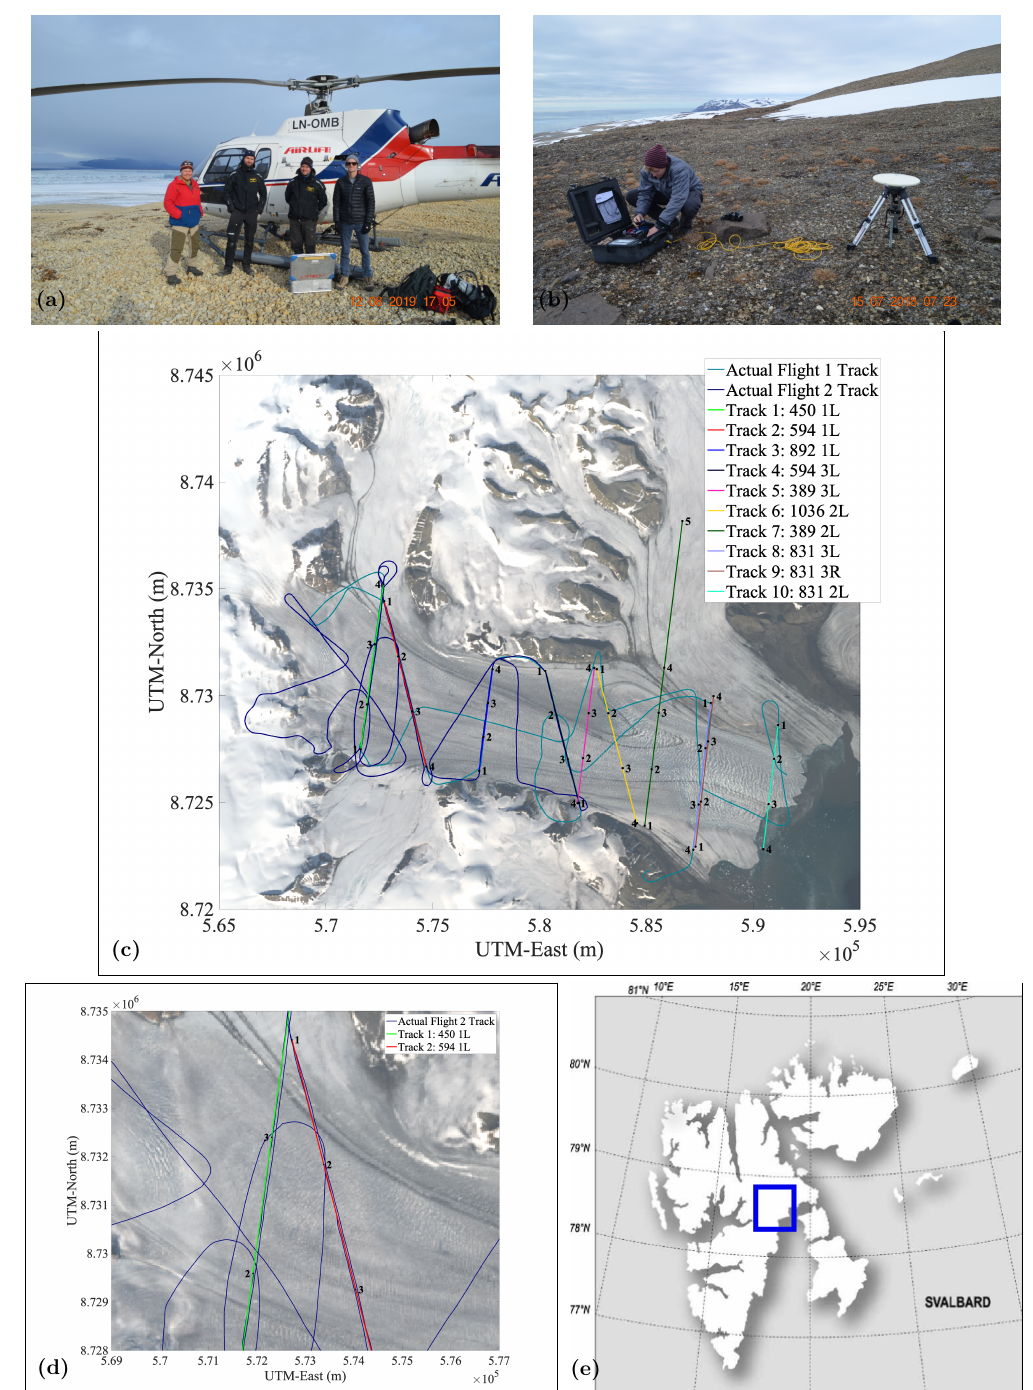
Figure 3. Negribreen ICESat-2 Airborne Validation Campaign 2019: Experiment setup, track maps, lo- cation map and satellite image. ( a ) Field team 2019 (f.l.t.r. Ute Herzfeld, Harald Sandal (pilot) and Gus- tav Svanström (technician), Matthew Lawson, in front of the Airlift/ NPI helicopter; photograph by Thomas Trantow), on the side of Negribreen, flight 1, 12 August 2019, ( b ) GPS base station on a ridge above Negribreen, 2018 (Connor Myers), photograph by Ute Herzfeld. ( c ) Planned and actual flight tracks and predicted ICESat-2 ATLAS ground tracks. Flight 1, 12 August 2019; Flight 2: 13 August 2019. Background Landsat-8 data (5 August 2019) [LC08_L1TP_215003_20190805_20190820_01_T1]. ( d ) Zoom into ( c ) for area of RGT 594 and RGT 450 analyzed in this paper. ( e ) Location map. (Figure panels ( c – e ) after